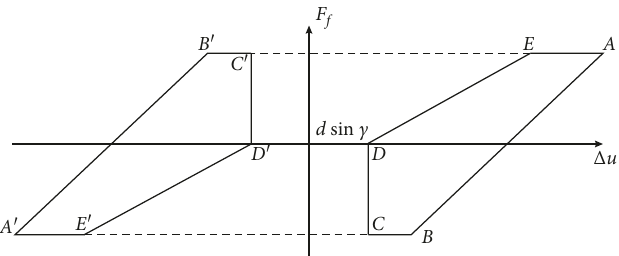
Figure 2: Hysteretic loops of friction force vs relative